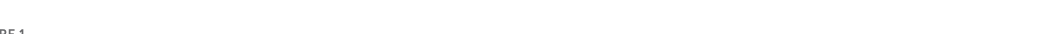
FIGURE1 Evolutionary scenarios of SLR-bearing chromosomes and their homologs in different possible types of polyploid plants under male heterogamety, assuming different possible types of sex-determination; A, autosomes. The thick arrows indicate evolutionary changes, and the thin ones indicate crosses and gamete formation, and when the lines are dashed, this indicates that the cross has low fertility. Red crosses indicate recombination between chromosomes that pair at meiosis (for general meiosis behavior of polyploids see Supplementary Figure 1 ). (A) The three main phases of sex chromosome evolution in a diploid dioecious progenitor of a polyploid species; many plants appear to be in stages with no, or minor, degeneration. Reversals to autosomes can occur when the ancestral X-Y pair is replaces by a new set of sex-determining chromosomes. (B) Classical “balance” model by Muller (1925) for sex determination via the X/A ratio in species with degenerated sex chromosomes, as in many animals (including Drosophila , nematodes and, with female heterogamety, Lepidoptera) (Bachtrog et al., 2014), showing that polyploids can neither maintain stable X/Y ratios nor restore the heterogametic sex. This form of sex-determination appears to be rare in angiosperms. (C) An autopolyploid plant originated via unreduced female gametes (termed a “triploid bridge,” because a triploid generation is initially formed by unreduced gametes of one parent, and can produce haploid, diploid, and triploid gametes; the * denotes low fertility of this generation). The diagram shows the expected progeny types assuming codominant expression of a Y-linked male-determining factor, and no preferential pairing of homologs (possible xyyy genotypes not shown). (D) Autopolyploid with a dominant Y-linked factor; xxxY genotypes represent fertile males. After some time two of the x may revert to autosomes A, whereas recombination between the xY pair prevents degeneration. (E) Allopolyploid origins via unreduced gametes of both parents (shown in green and gray), and with a dominant Y-linked maleness factor. Homologs of the same parent will preferentially pair at meiosis (see also Supplementary Figure 1 ). Initially only xxxY male allopolyploids can be formed and produce heterozygous male gametes (see text). Backcrossing with unreduced gametes of female parents can produce various tetraploid hybrid genotypes, including both xxxx females and xxxY males, resulting in stable populations. Here also two of the x may revert to autosomes (A) , and only one possible recombining xY pair (derived from the same progenitor) remains. Further hybridization with a third species can result in a hexaploid, which eventually results in reversal to a non-dioecious system.